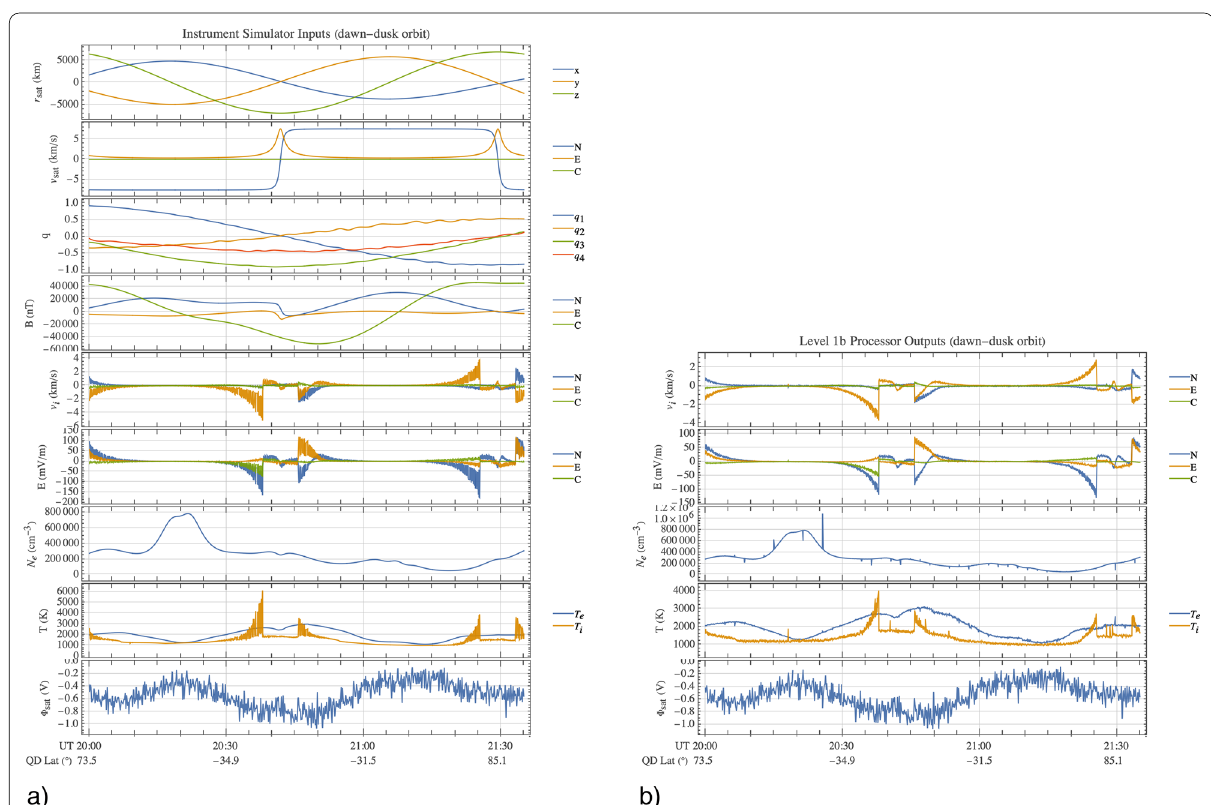
Fig. 3 Level 0 and 1b outputs of the EES. a Example model outputs (16 Hz) from the EES for a dawn–dusk orbit at 530 km altitude. From top to bottom: satellite position, satellite velocity, satellite attitude quaternions, magnetic field, ion velocity, electric field, electron concentration, electron and ion temperatures, and satellite potential. b Example level 1b outputs (2 Hz) generated by processing data corresponding to the example at left. From top to bottom: ion velocity, electric field, electron concentration, electron and ion temperatures, and satellite